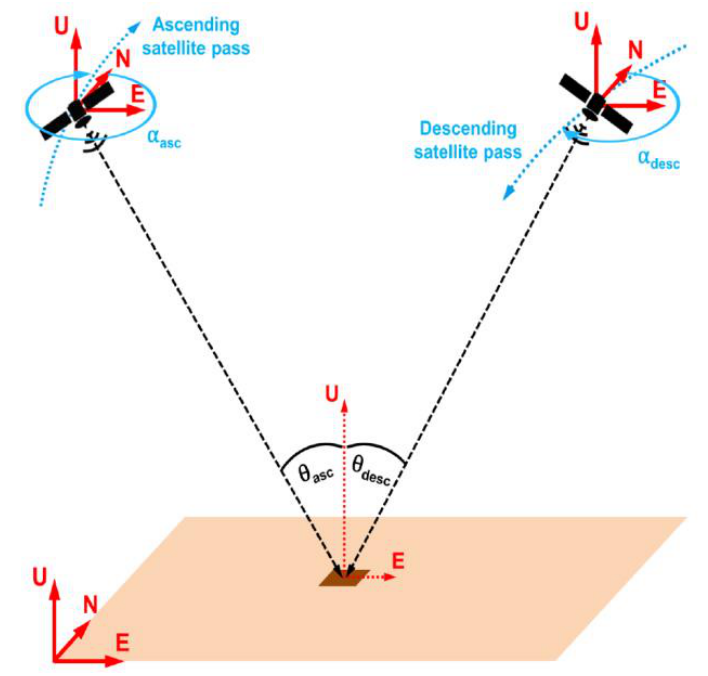
Figure 4. InSAR geometry, taken from [11] (originally published under Creative Commons Attribution license (CC BY)).